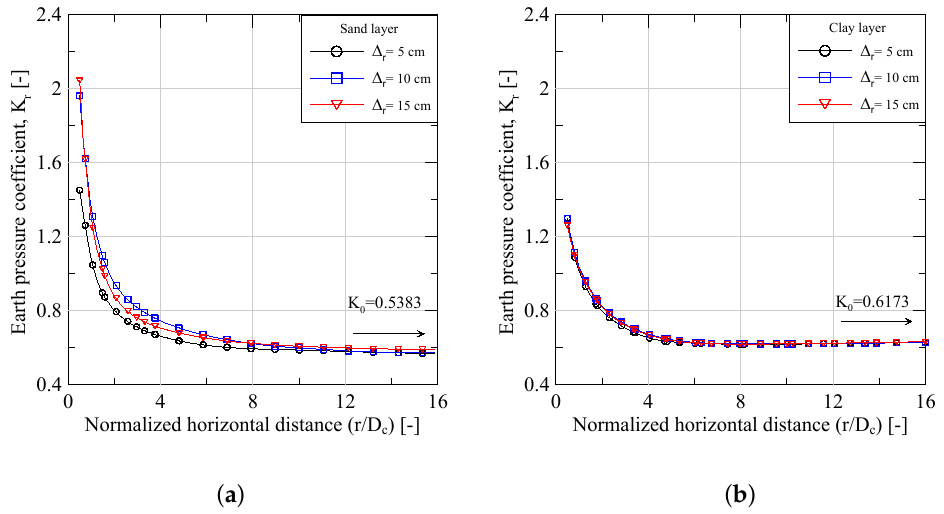
Figure 11. Coefficient of earth pressure distribution after consolidation: ( a ) sand layer; ( b ) clay layer. The radial earth pressure coefficient K r shows significant increases from the initial value of K 0 , extending to distances greater than 12 times the column diameter D c in the sand layer, see Figure 11a, but less than six times the column diameter in the clay layer, see Figure 11b. For ∆ r = 15 cm, the sand and clay layer improvement is approximately 3.7 and 2.1 times the K 0 , respectively. The figure shows that improvement in the sand is more extensive than in the clay layer, and this improvement is affected by the degree of expansion. These distributions of earth pressure coefficients are similar to those discovered by